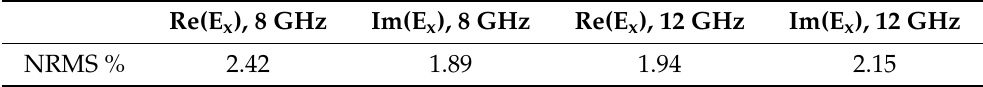
Figure 7. The real and imaginary part of the total electric field inside three-layer media with dimensions 30cm (cid:101) r ,1 = 1.16 for the dielectric layer at 8GHz and 12GHz. Layer 2 is PEC. Table 3. NRMS value for compared analytical model and FEM in Figure 7.